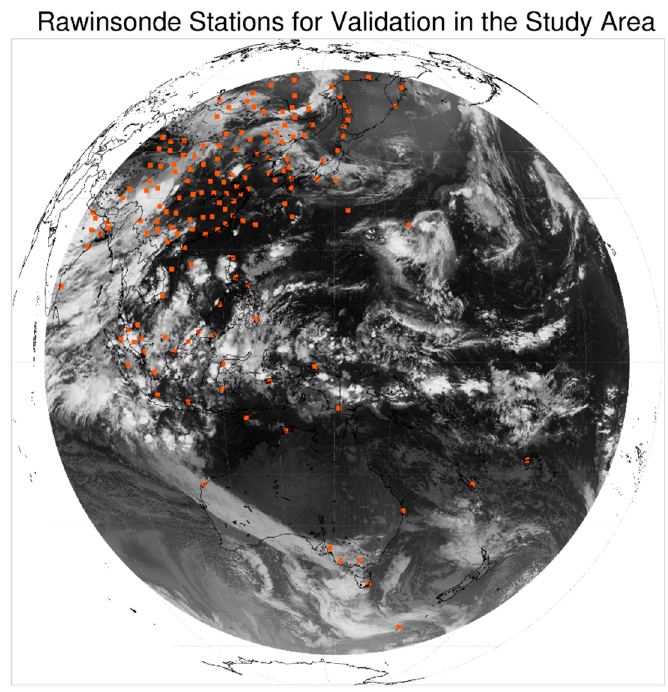
Figure 1. Station information of rawinsonde captured at 12:00 UTC on 21 July 2016. The background plot is the CH13 (10.2 µ m) brightness temperature of AHI over our study area. In this full disk area of AHI, the total number of stations is about 160. The nominal time of the rawinsonde launch was 0000 or 1200 UTC, with occasional launches occurring at 06:00 and 18:00 UTC.